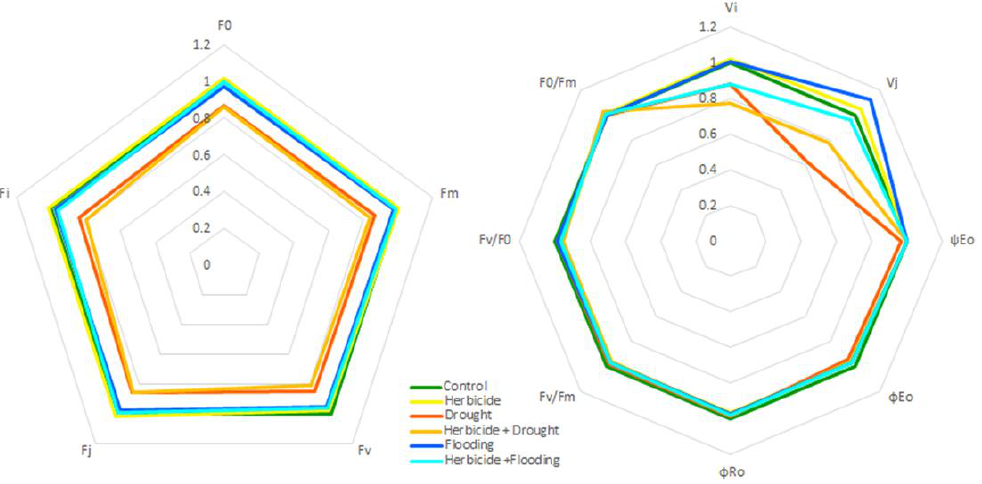
Figure 5. Spider plot of the chlorophyll fluorescence parameters in wheat plants after 4 days of drought or flooding.